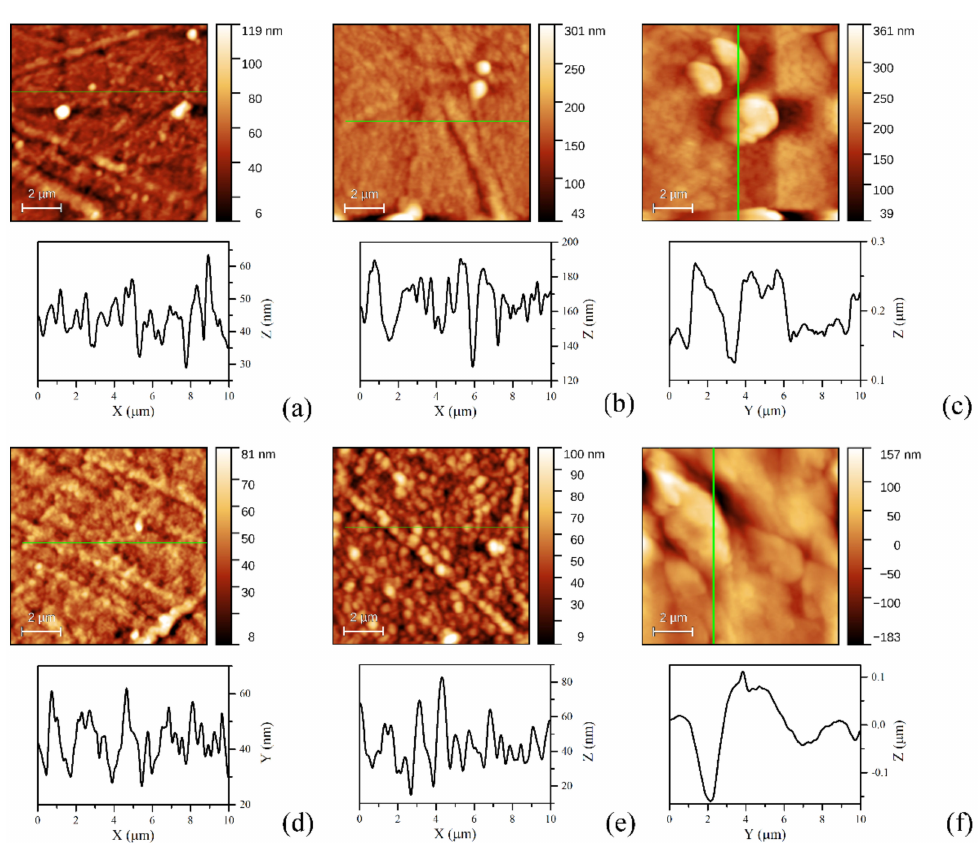
Figure 6. Typical AFM images and profile line for PET/AZO/ZnPc ( a ), PET/AZO/L13 ( b ), PET/AZO/L78 ( c ), PET/AZO/ZnPc/TPyP ( d ), PET/AZO/L13/TPyP ( e ), PET/AZO/L78/TPyP ( f ). The substrates are indicated in Table